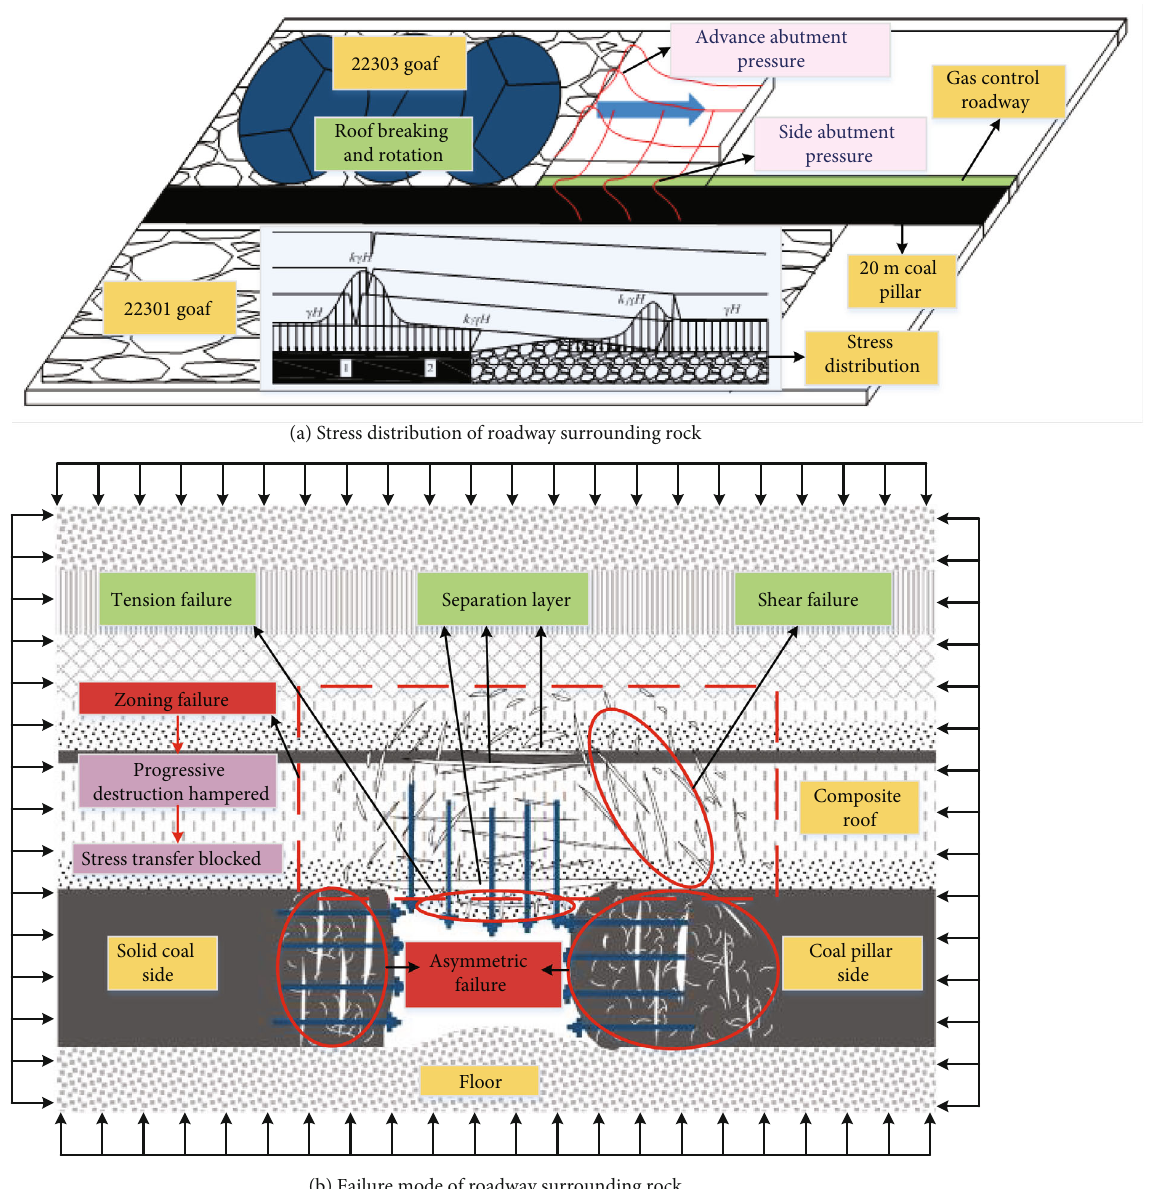
Figure 9: Instability form of multiple dynamic pressure disturbance of surrounding rock in compound roof